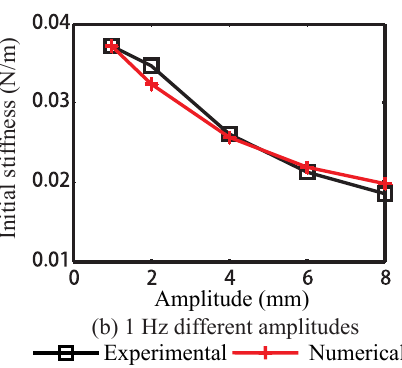
Fig. 12. Comparison of energy dissipation stiffness between experi- mental and numerical results.